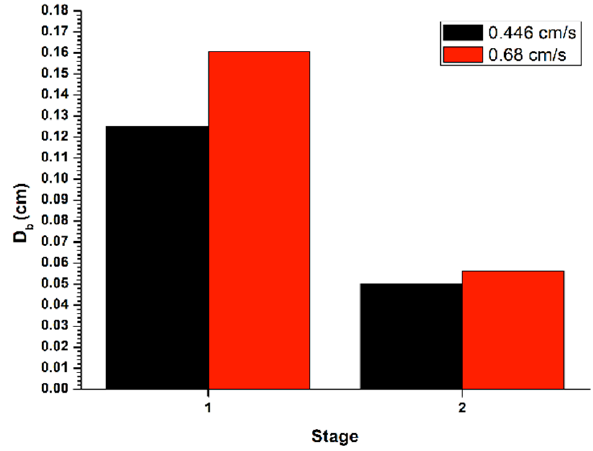
Figure 4. Determination of D b in the batch flotation column of the material of the Dos Carlos dam, for J lT of 0.446 & J lT of 0.68 cm / s, 50 ppm C 12 H 25 NH 2 as a collector, and 60 ppm MIBC as foaming agent.